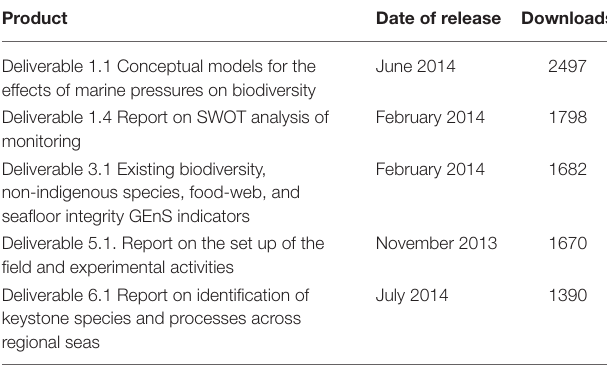
TABLE 3 | First five products most downloaded from the DEVOTES website